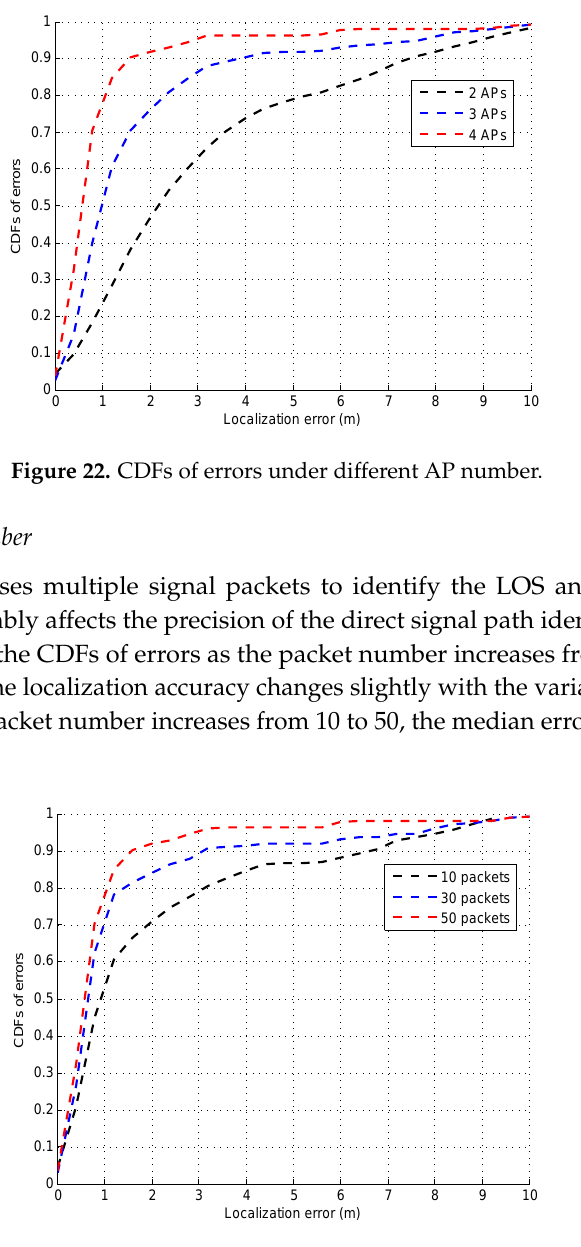
Figure 23. CDFs of errors under different packet